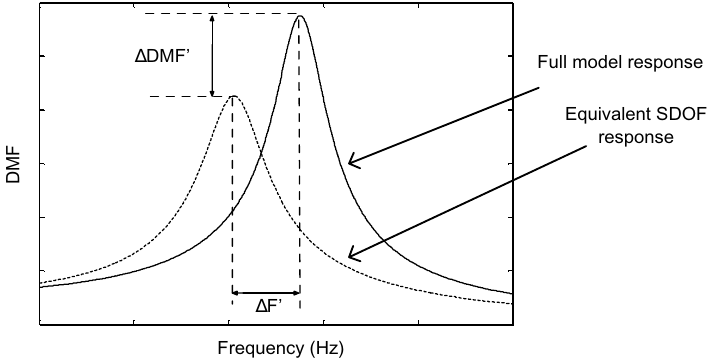
Fig. 6. Illustrations on peak DMF and resonant frequency relative errors.